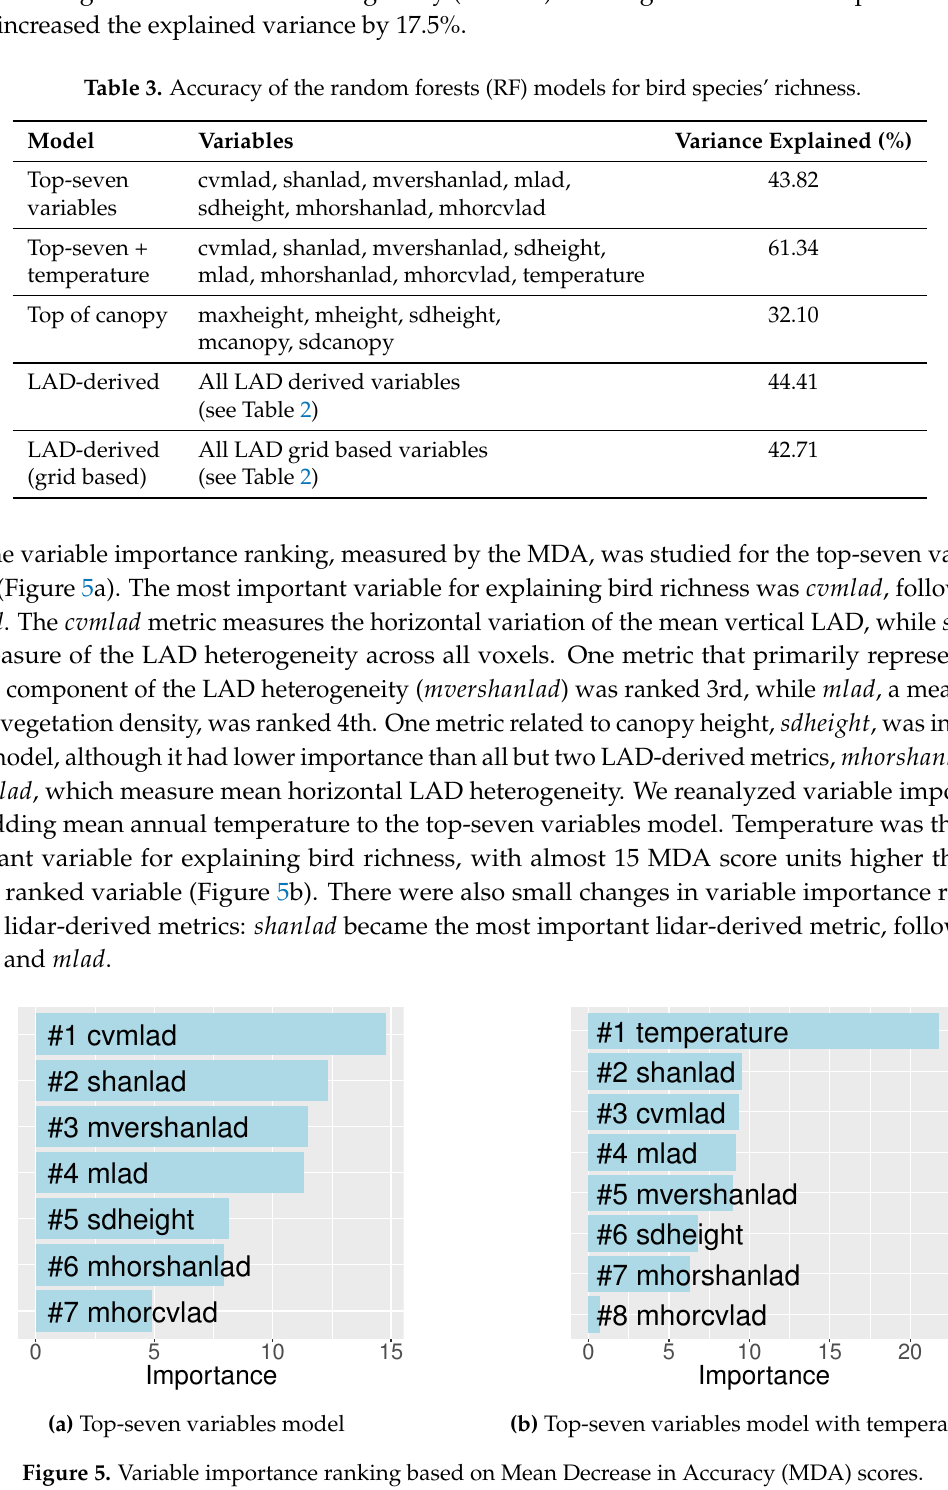
Figure 5. Variable importance ranking based on Mean Decrease in Accuracy (MDA)